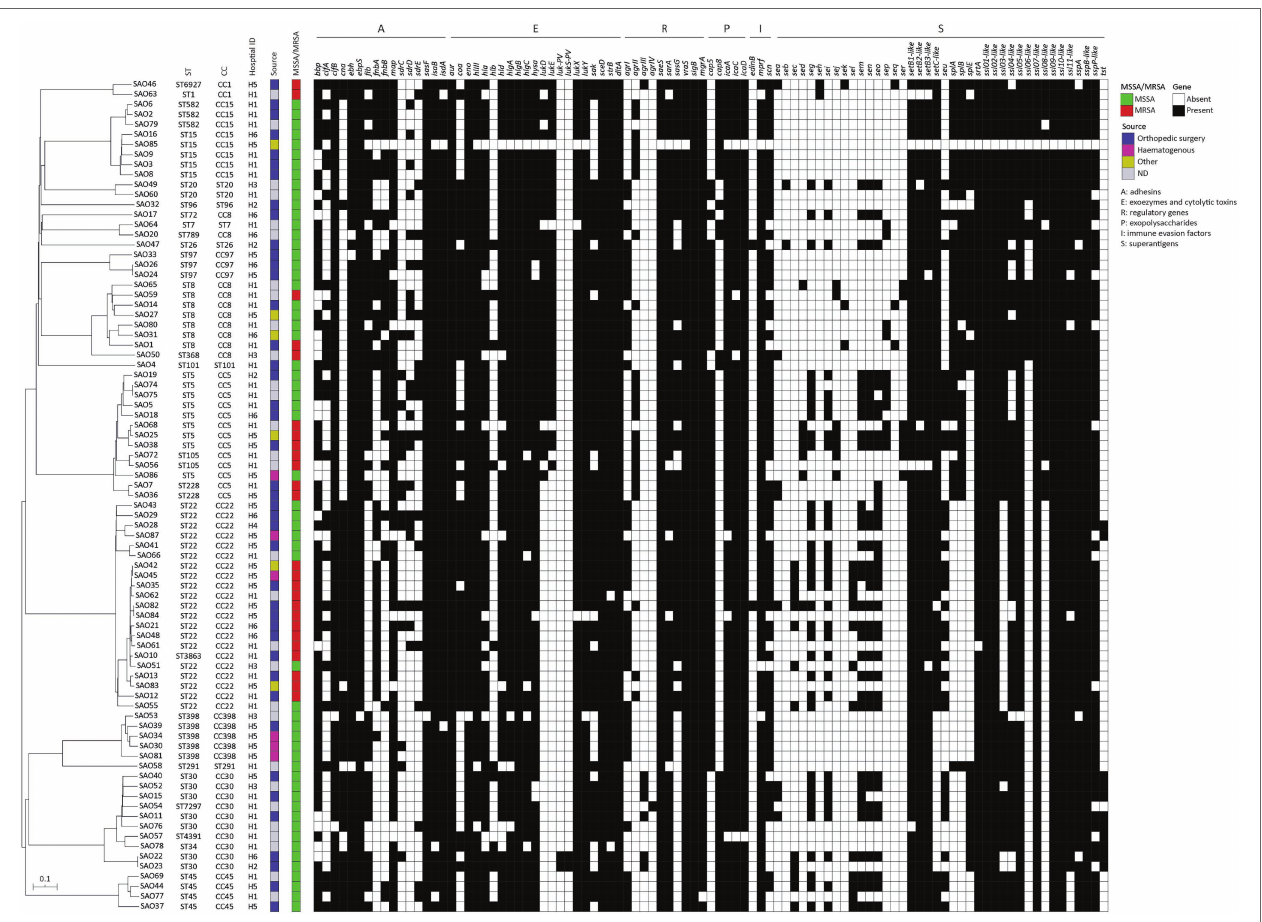
FIGURE 2 | Neighbor joining (NJ) tree based on the allelic profiles of the cgMLST target genes ( n = 1,861) of 83 Staphylococcus aureus isolates from osteomyelitis in Italy, and associated heat-map of in silico detected virulence genes (indicated on